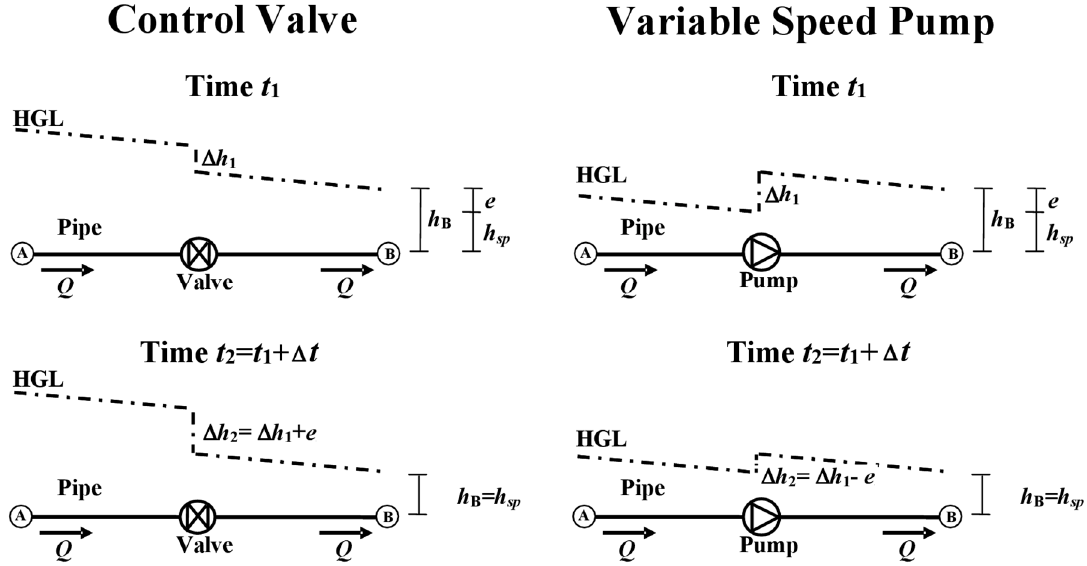
Figure 1. Schematic for the description of the operation of logic controller for the control valve (left) and for the variable speed pump (right): situation at the current (above) and new (below) times. HGL stands for head grade line.